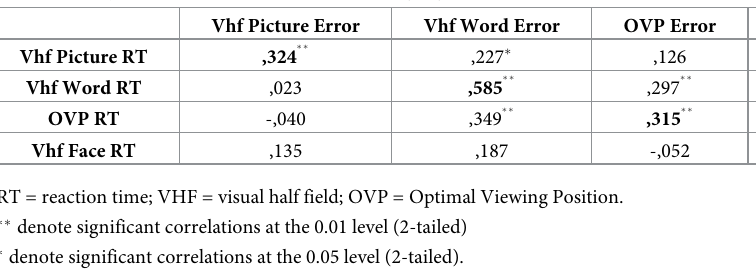
scatter plot, i.e. the quarter with participants that have a positive LI for both the word and pic- ture task as expected based on the literature and the significant correlation reported in 3.2.1 ( r = .34, p < .01). We plot data from the same tasks tested in 250 left-handers in [4] in Panel B for a comparison with the current study. For this study, the VHF picture and word LIs recalcu- lated with formula (1) correlated with a value of r = .46, p < .001. 77% participants fell in the LH/RH category for both tasks when taking an LI cutoff of 0 compared to 63% in the current study. The LIs correlated most highly with LIs measured in an fMRI word generation task when only taking into account participants that showed clear (i.e. with a 10 ms VHF cut-off)